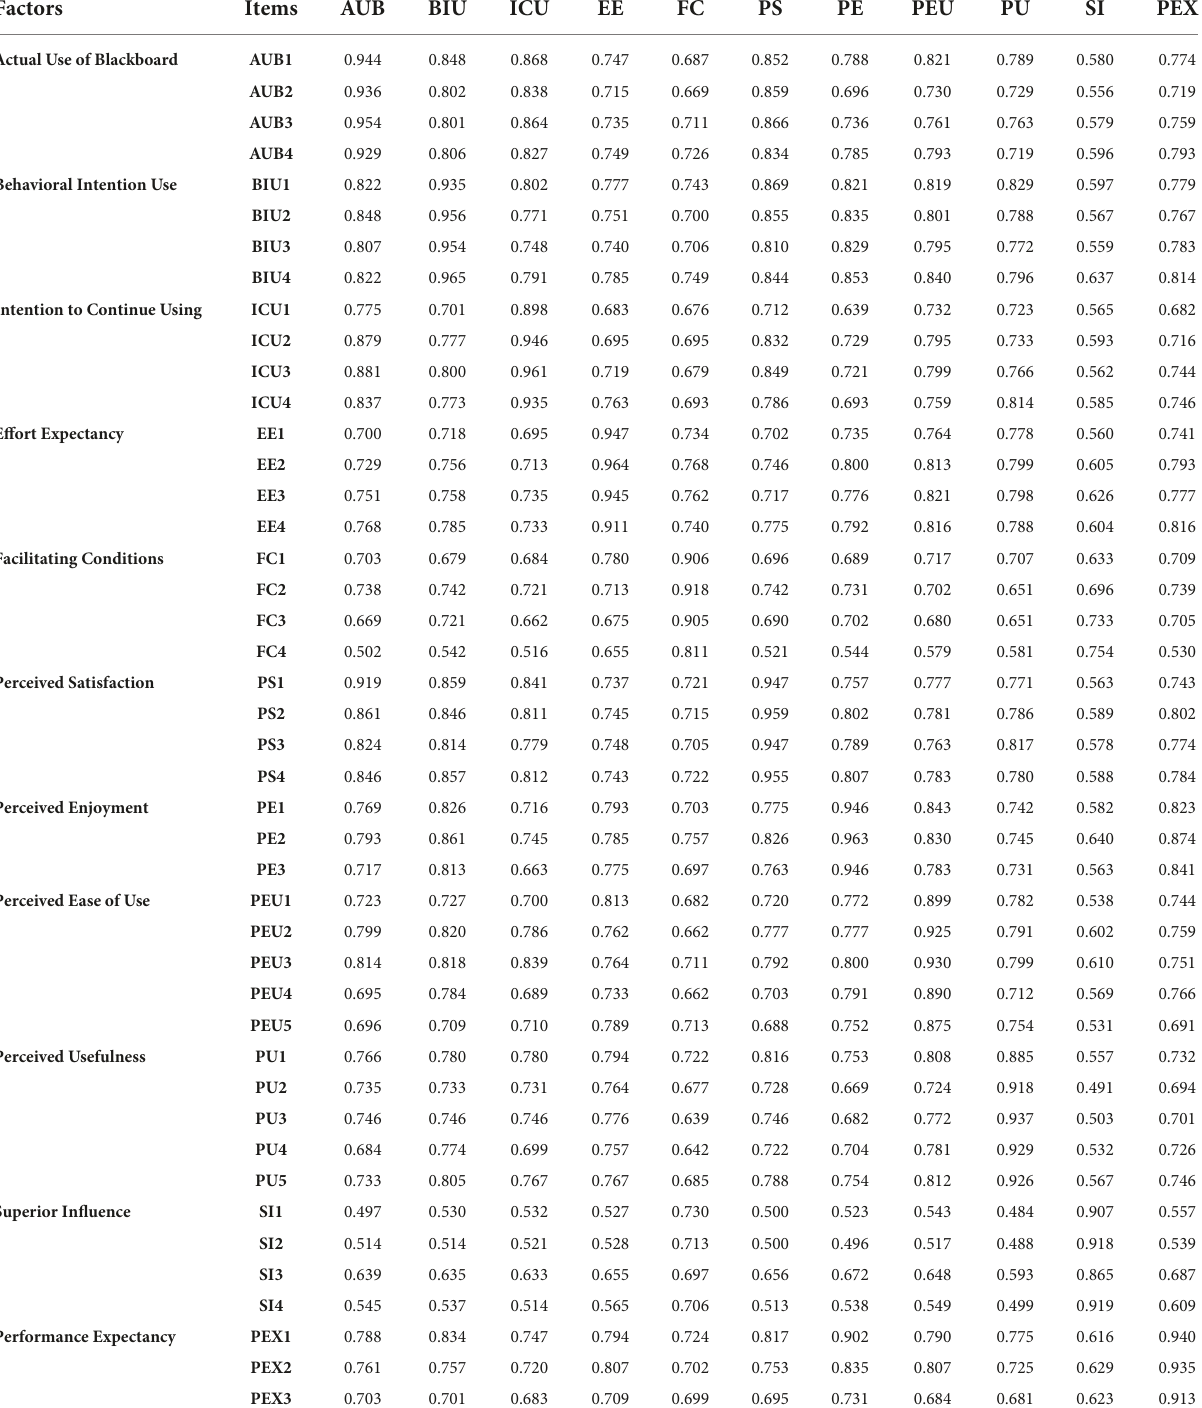
TABLE 2 Factors loadings and cross-loadings of items.